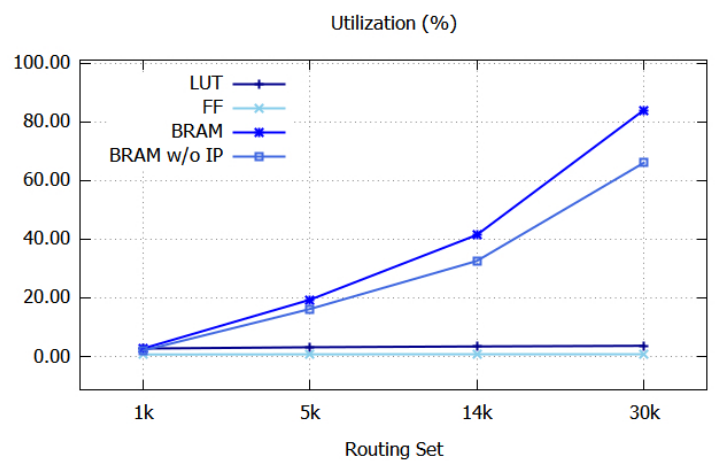
Figure 8. Resource